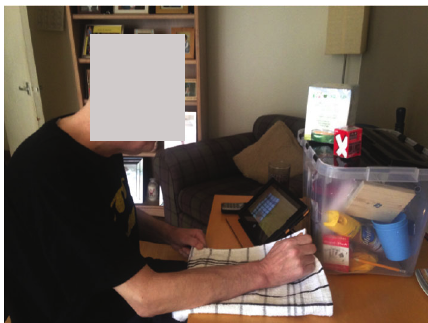
Figure 2: An individual using the SIMULATe application at home to practice one of the ADLs in the library (pinching the ends of a tea towel and folding it over). The individual in this manuscript has given written informed consent to publish this photograph.